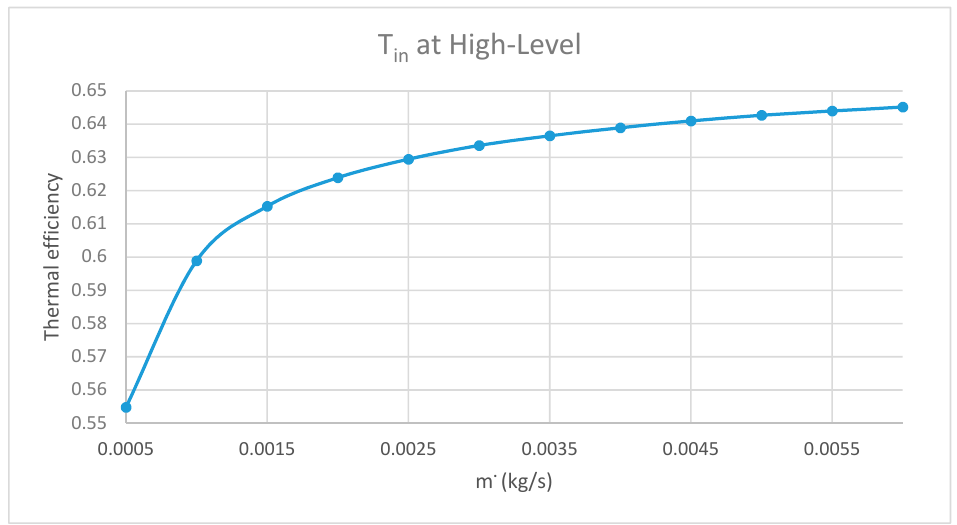
Figure 11. The effect of inlet flowrate on (cid:2015) (cid:3047)(cid:3035) at High-Level inlet temperature.